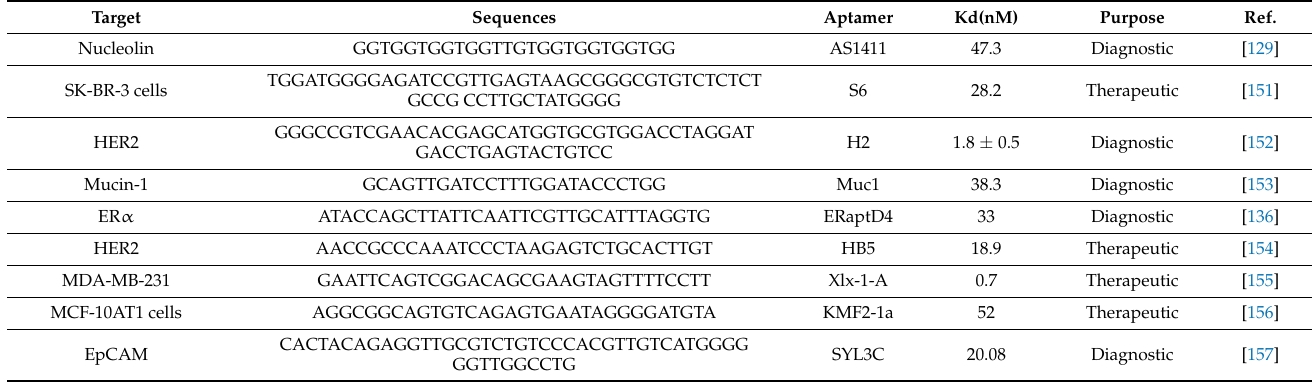
Table 3. Aptamer application in breast